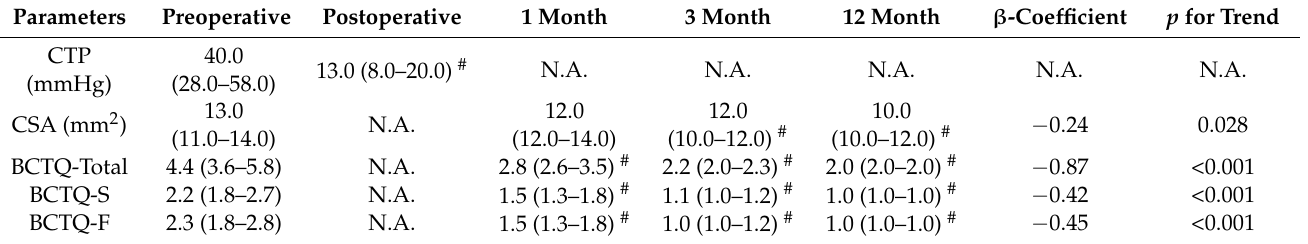
Table 1. Clinical outcomes before and after percutaneous ultrasound-guided carpal tunnel